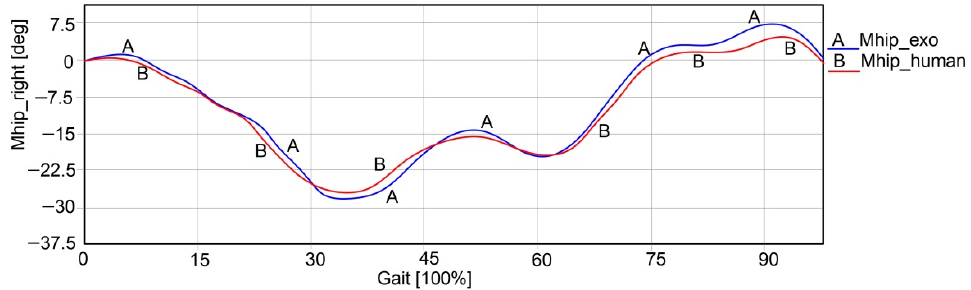
Figure 33. Left knee angular variation exoskeleton vs. human subject during a complete gait. Figure 34. Left ankle angular variation exoskeleton vs. human subject during a complete gait.